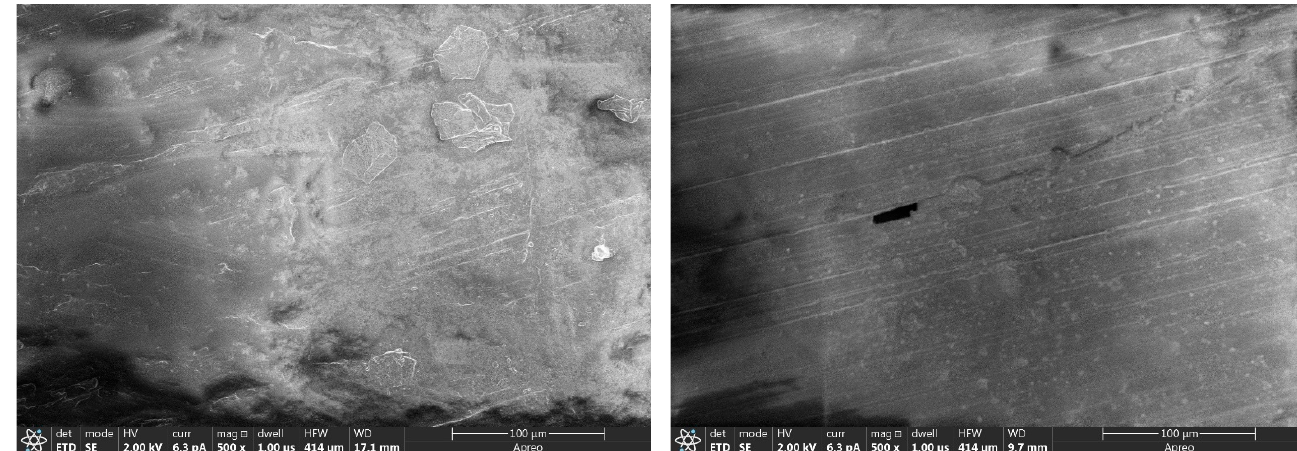
Figure 5. SEM images of PA6/GO (left) and PA6/GO_PAAM (right) nanocomposites.